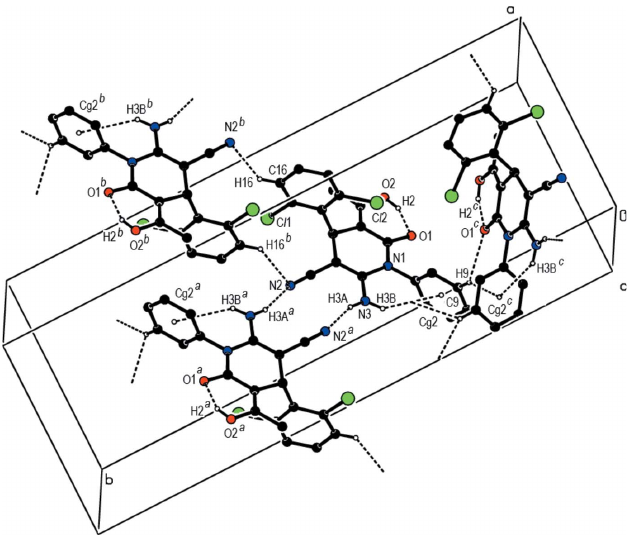
Figure 2 A general view of the intra- and intermolecular O—H (cid:2)(cid:2)(cid:2) O, N—H (cid:2)(cid:2)(cid:2) N hydrogen bonding and N—H (cid:2)(cid:2)(cid:2) (cid:2) and C—H (cid:2)(cid:2)(cid:2) (cid:2) interactions in the title compound. Symmetry codes: ( a ) 1 (cid:5) x , 1 (cid:5) y , 2 (cid:5) z ; ( b ) 2 (cid:5) x , 1 (cid:5) y , 2 (cid:5) z ; (cid:5) y , 1 ( c ) x , 1 + z . 2 2